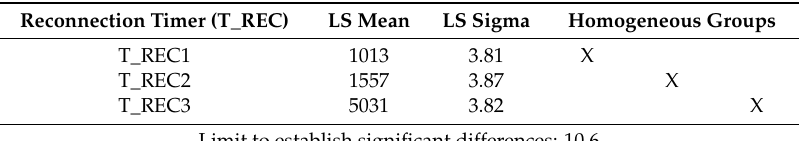
Table 8. Results of the Multiple Range Tests for the factor ACK Timer (T_ACK), using as dependent variable the Set-Up Energy (mWs).